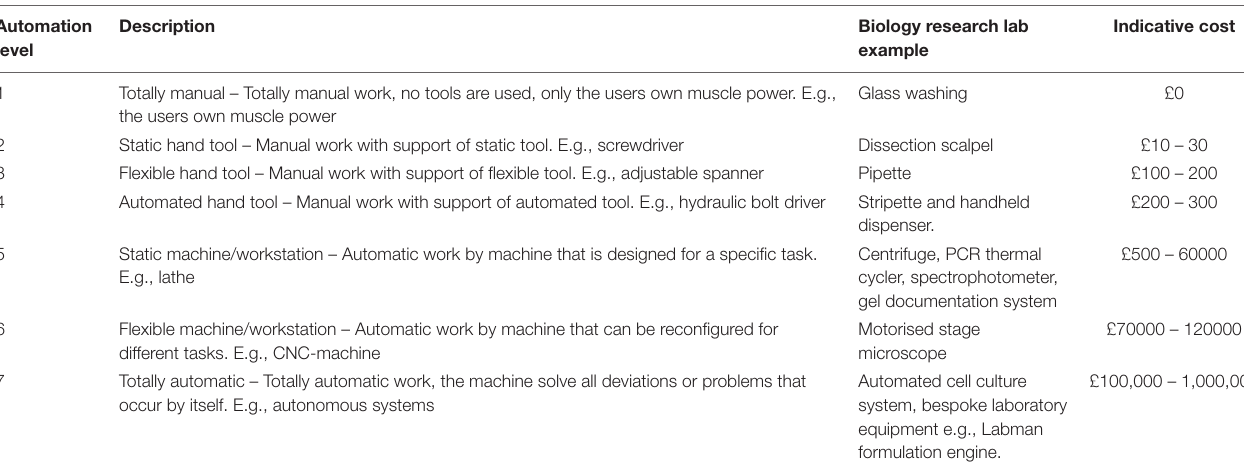
TABLE 1 | Automation levels (Frohm et al., 2008) with example laboratory automation equipment and an indicative cost